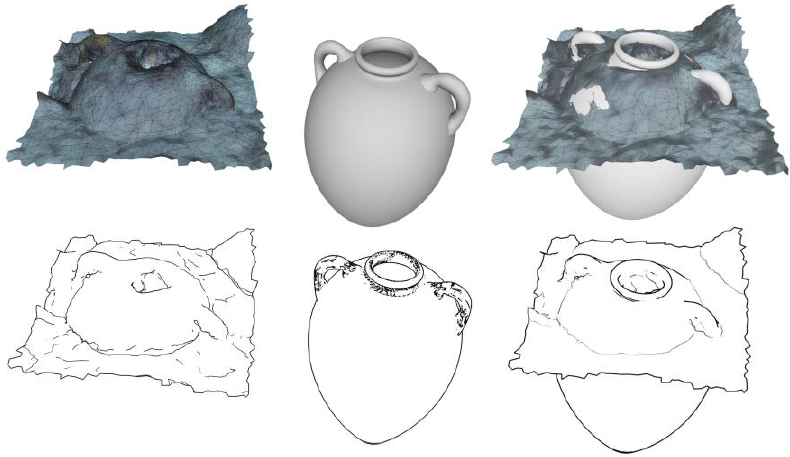
Figure 18. First row: Object recognition based on 3D models using point cloud representation. Second row: Illustration of object recognition using NPR representation.